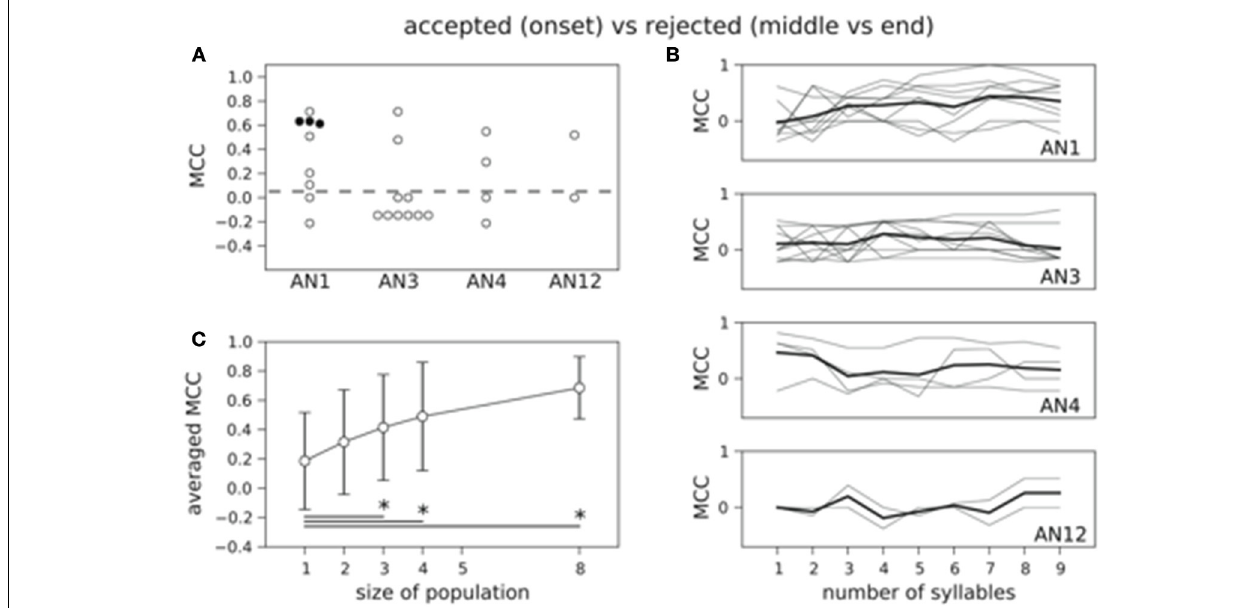
FIGURE 6 | Count based decoding of behaviorally relevant classes in single neurons and populations. (A) Decoding the class of accepted versus the class of rejected stimuli is in only 3 neurons successful. The distribution of the 25 MCC values does not differ significantly from the MCC distribution of the classifiers that are based on randomized counts ( p = 0 . 45, one-sided Wilcoxon rank-sum